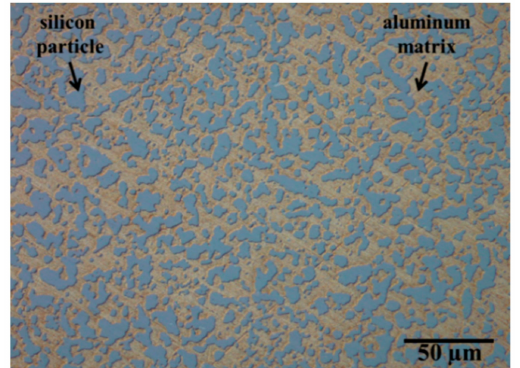
Figure 1. Optical micrograph of Al-42Si AR